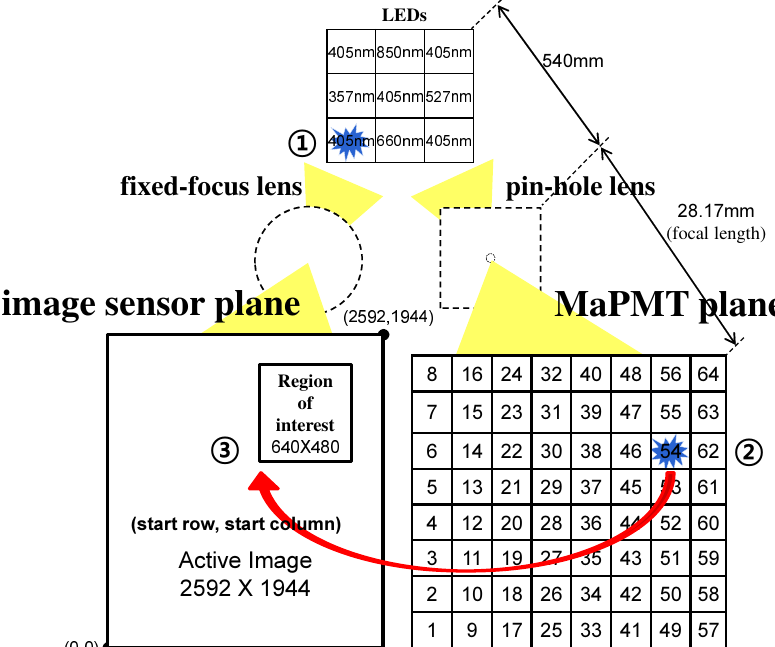
Figure 13. Scenario of the experiment on the ground simulation facility. First, a 405 nm UV LED blinks every 1 s and is turned on for 100 ms duration to emulate a blue jet. Next, as soon as the detector IP senses the flash light, it triggers the camera IP with the estimated location of the light. Finally, the camera IP captures successive images around the